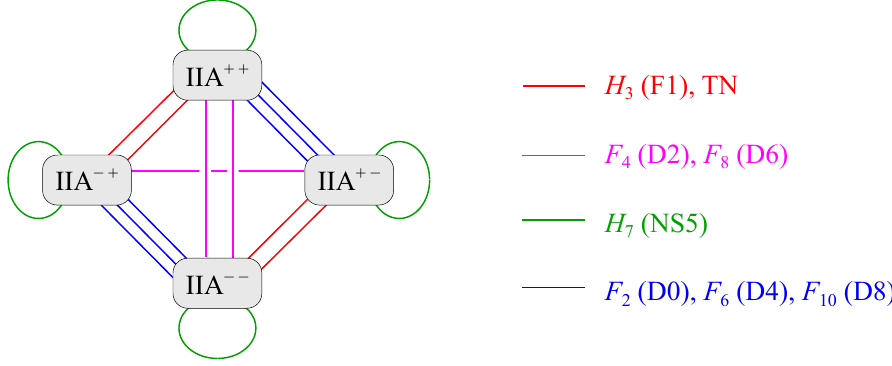
Figure 8 . The possible signature changing domain walls in type IIA string theory, with the spacetime signatures suppressed for simplicity.